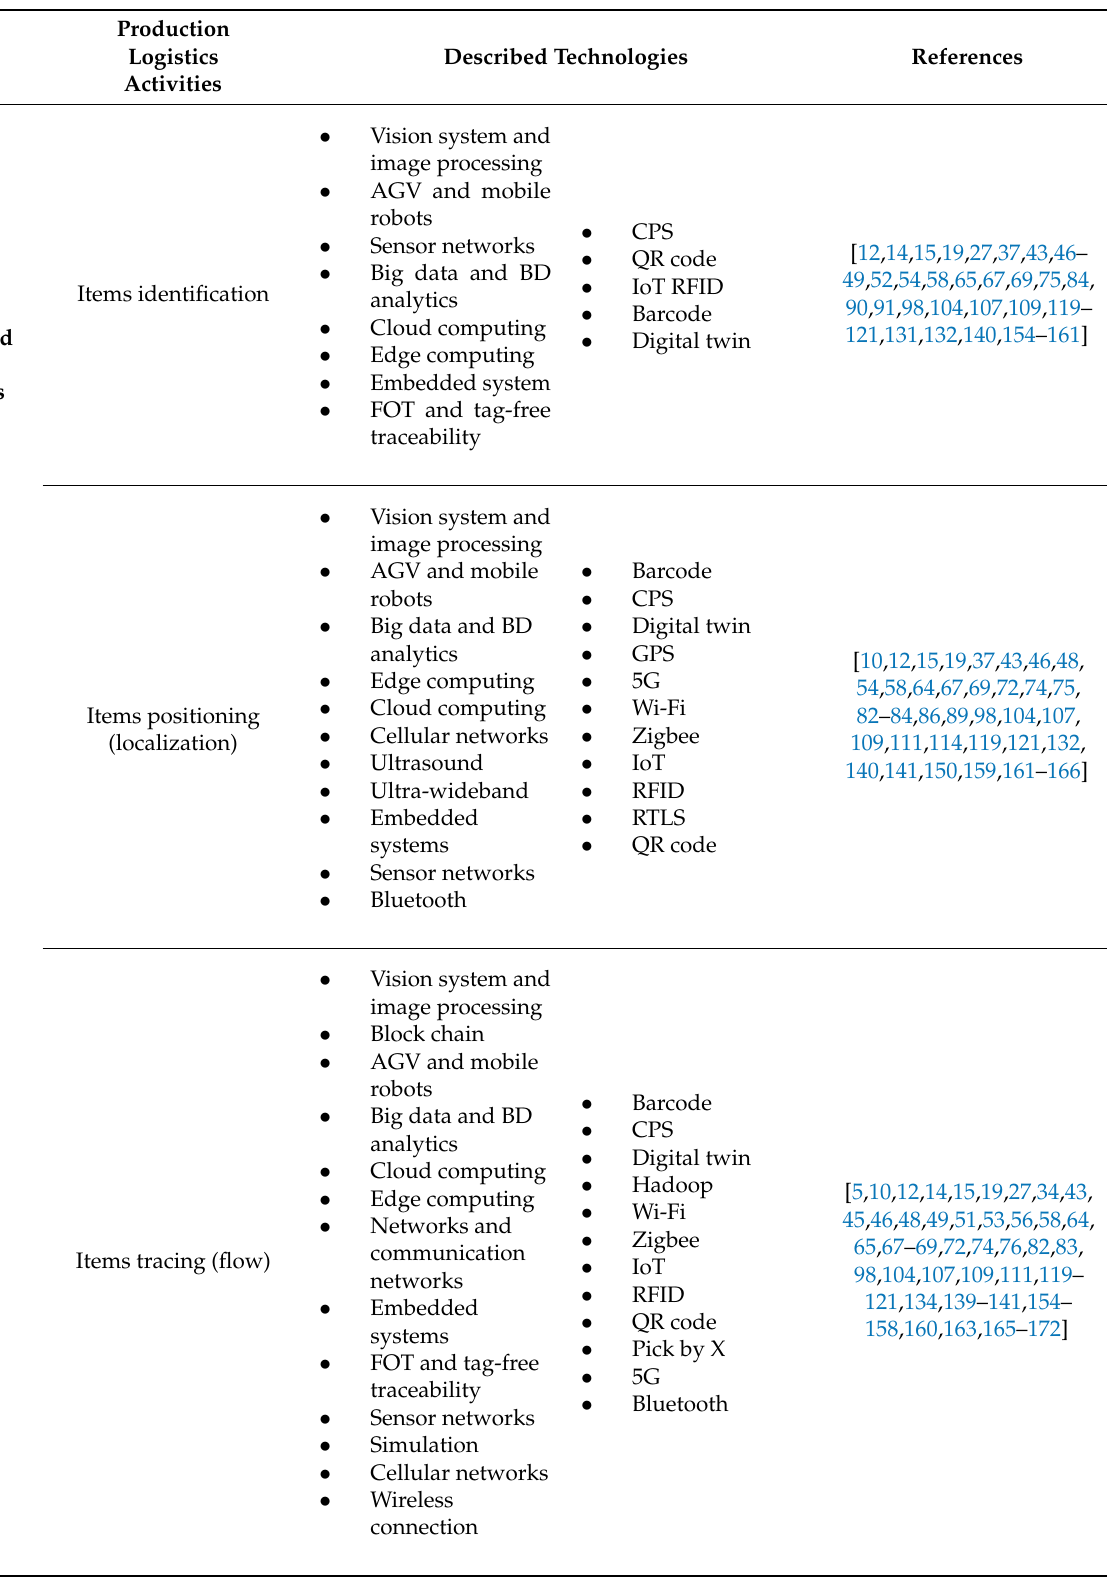
Table 5. Production logistics activities in Category 3 and association with the identified technologies in the